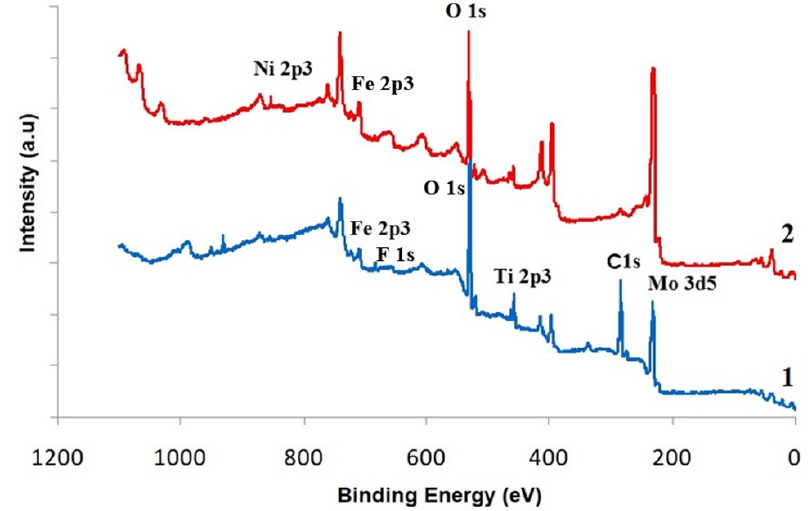
Figure 2. XPS spectra of a specimen with titanium-containing coating on steel prior to etching ( 1 ) and after 180 min etching of the coating ( 2 ).